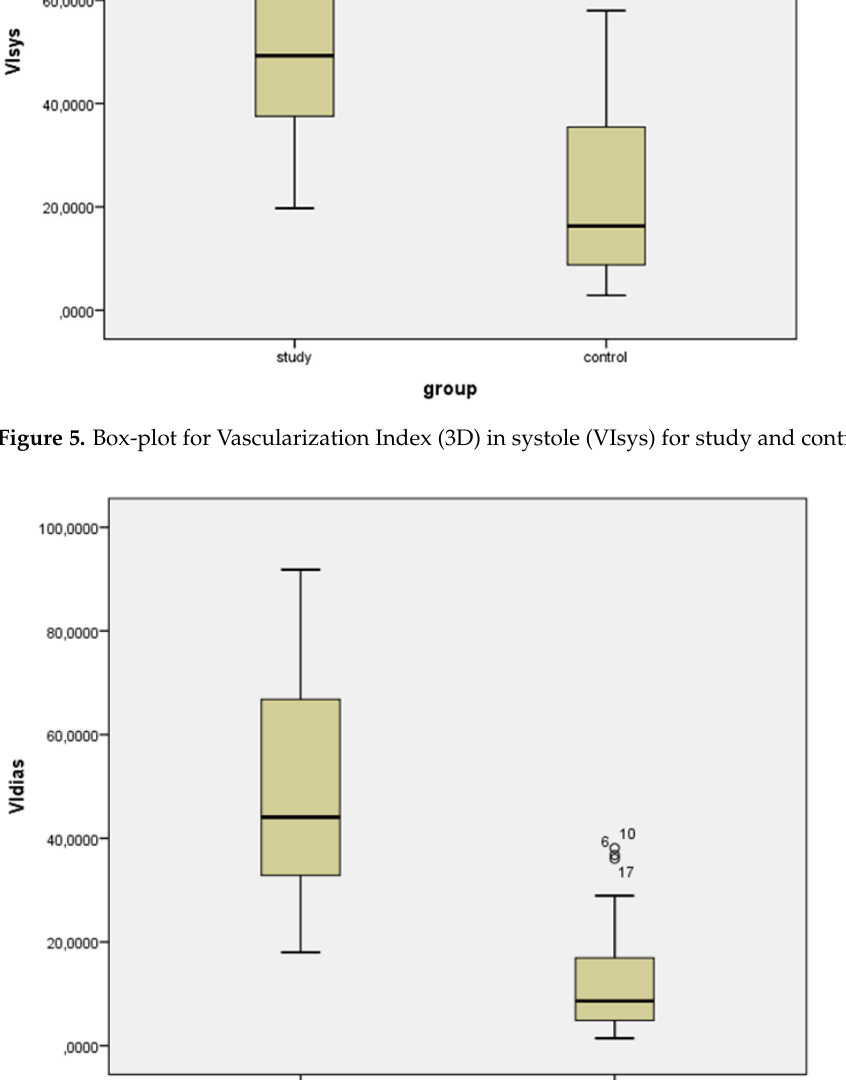
Figure 7. Box-plot for volumetric (4D) Systolic/Diastolic (vS/D) Index for study and control group.